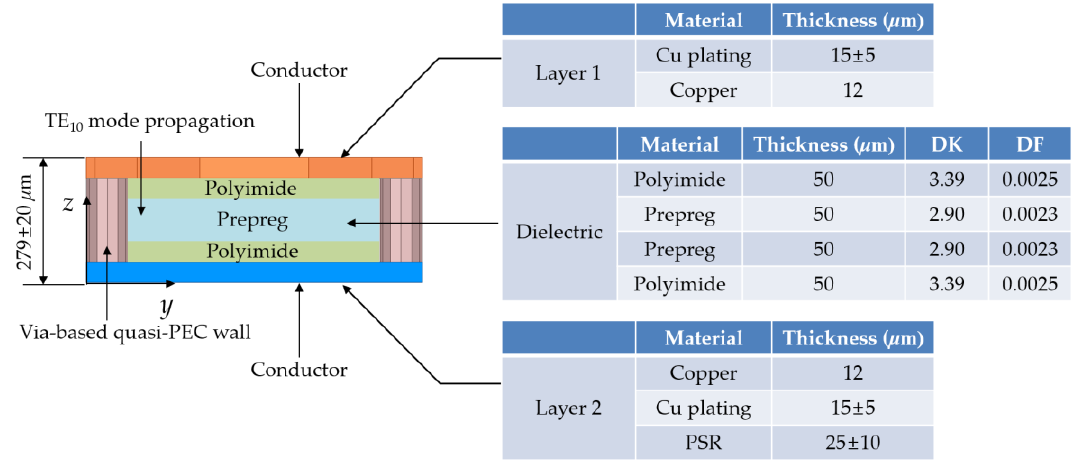
Figure 3. Stack-up of FPCB process for the experimental characterization of FMSIW and